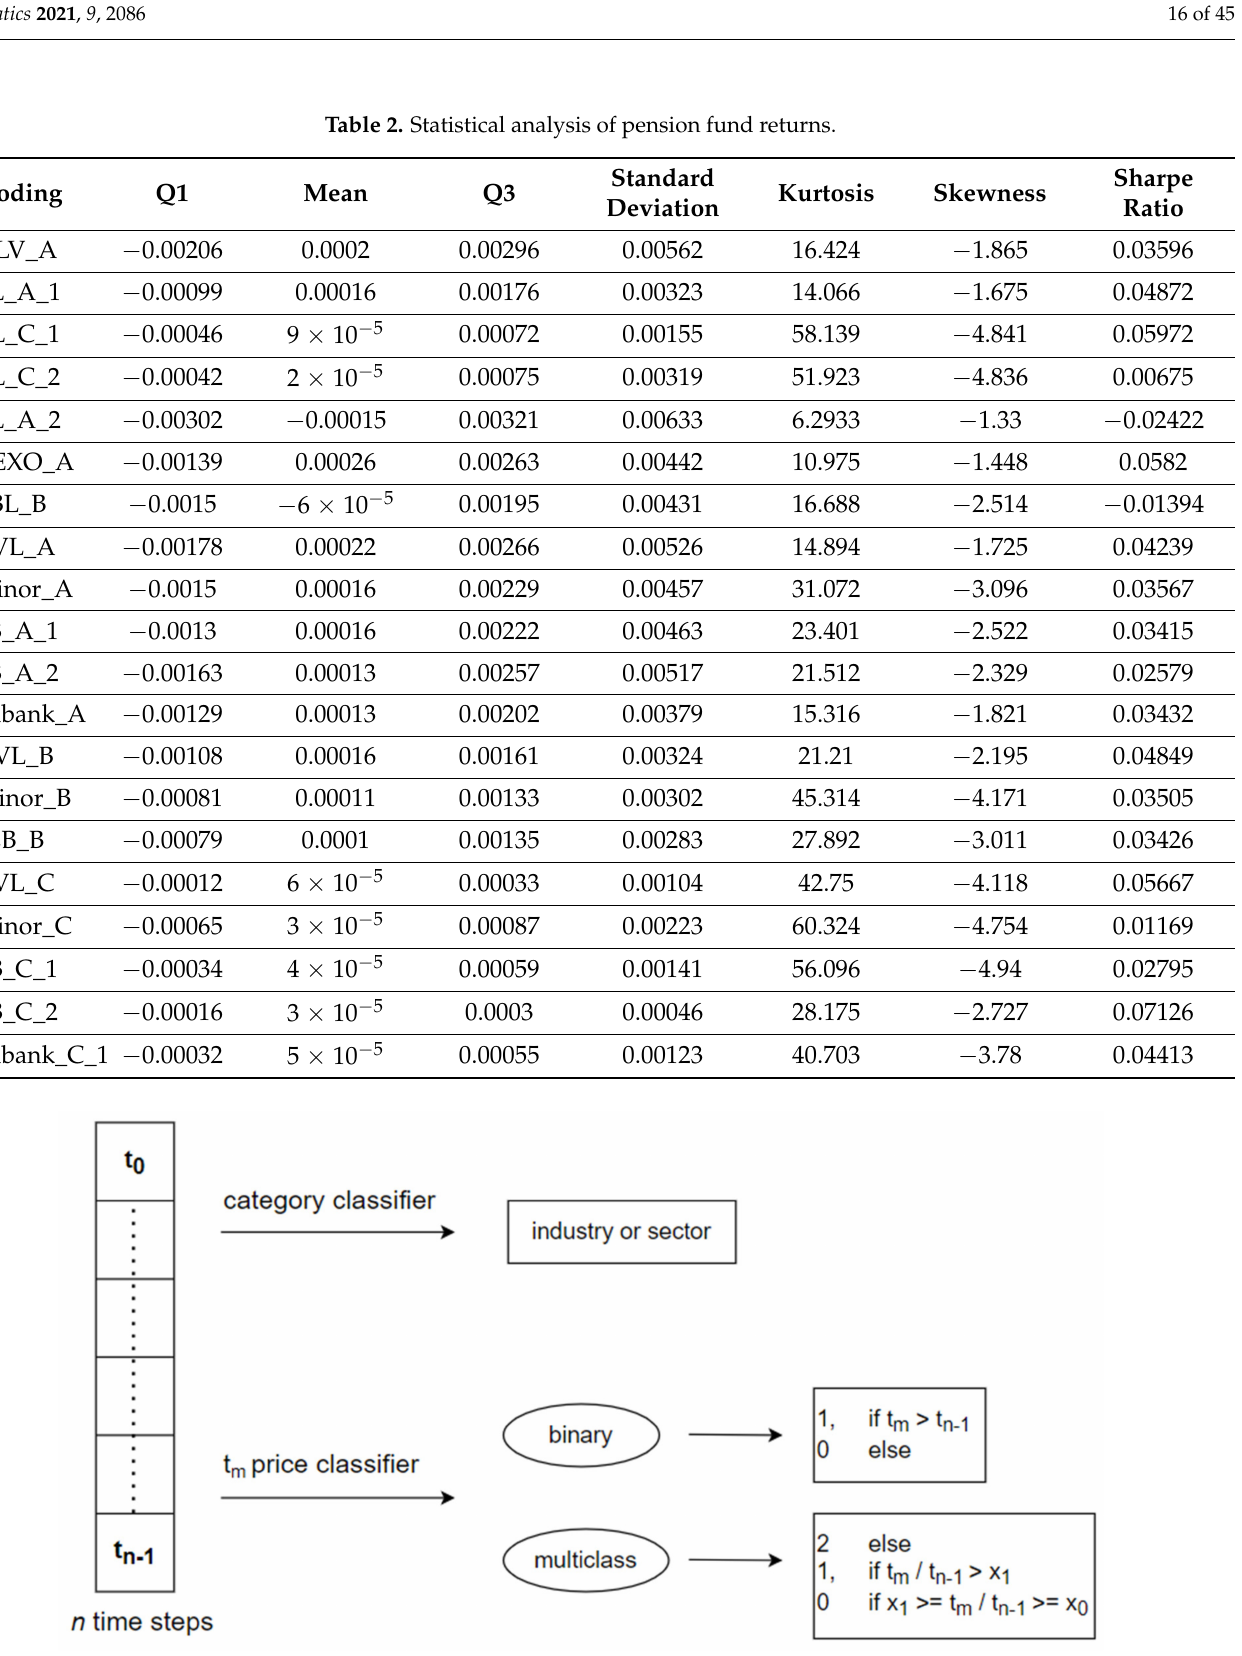
Figure 3. Time-series data labels are based on the type of classifier. Price classifier labels are denoted by comparing t n value with t m , where m > n